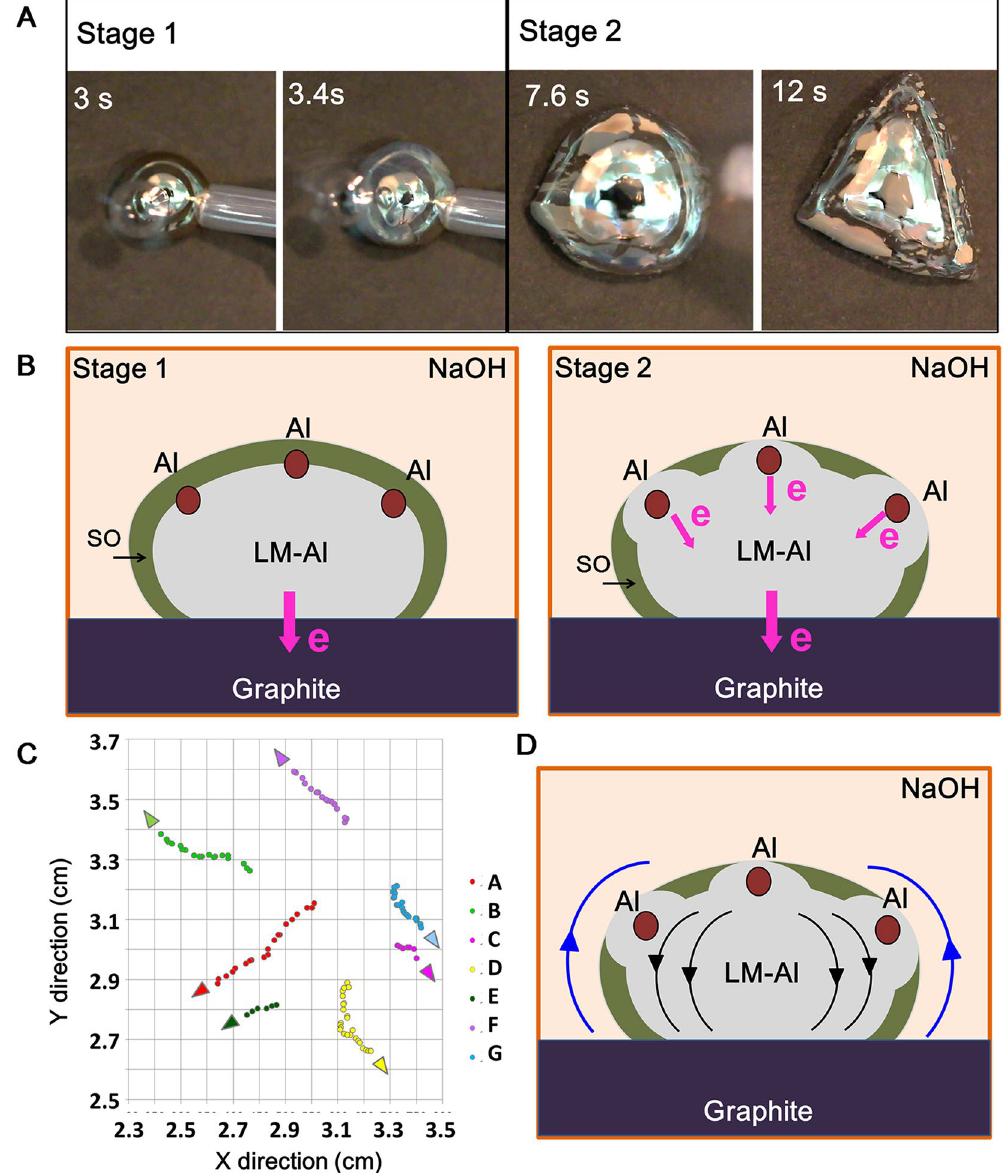
Figure 3. ( A ) The transformation of LM-Al droplet in Stage 1 and 2 in Case 2. ( B ) The schematic diagrams of the electrochemical status of LM-Al droplet in stage 1 and 2. The red dots indicate the evenly dispersed Al on the surface. The dark green periphery round region indicates the surface oxide (SO). ( C ) The trajectory of oxide cracks in Stage 2. The arrows indicate the moving directions of cracks. Each point was taken every 0.2 s. The points were traced at each frame of the video (2D) without concerning the 3D surface. ( D ) The surface out-dispersing of the LM-Al droplet. Black arrows indicate the surface flow directions. Blue arrows indicate the surface tension gradient from high to low across the